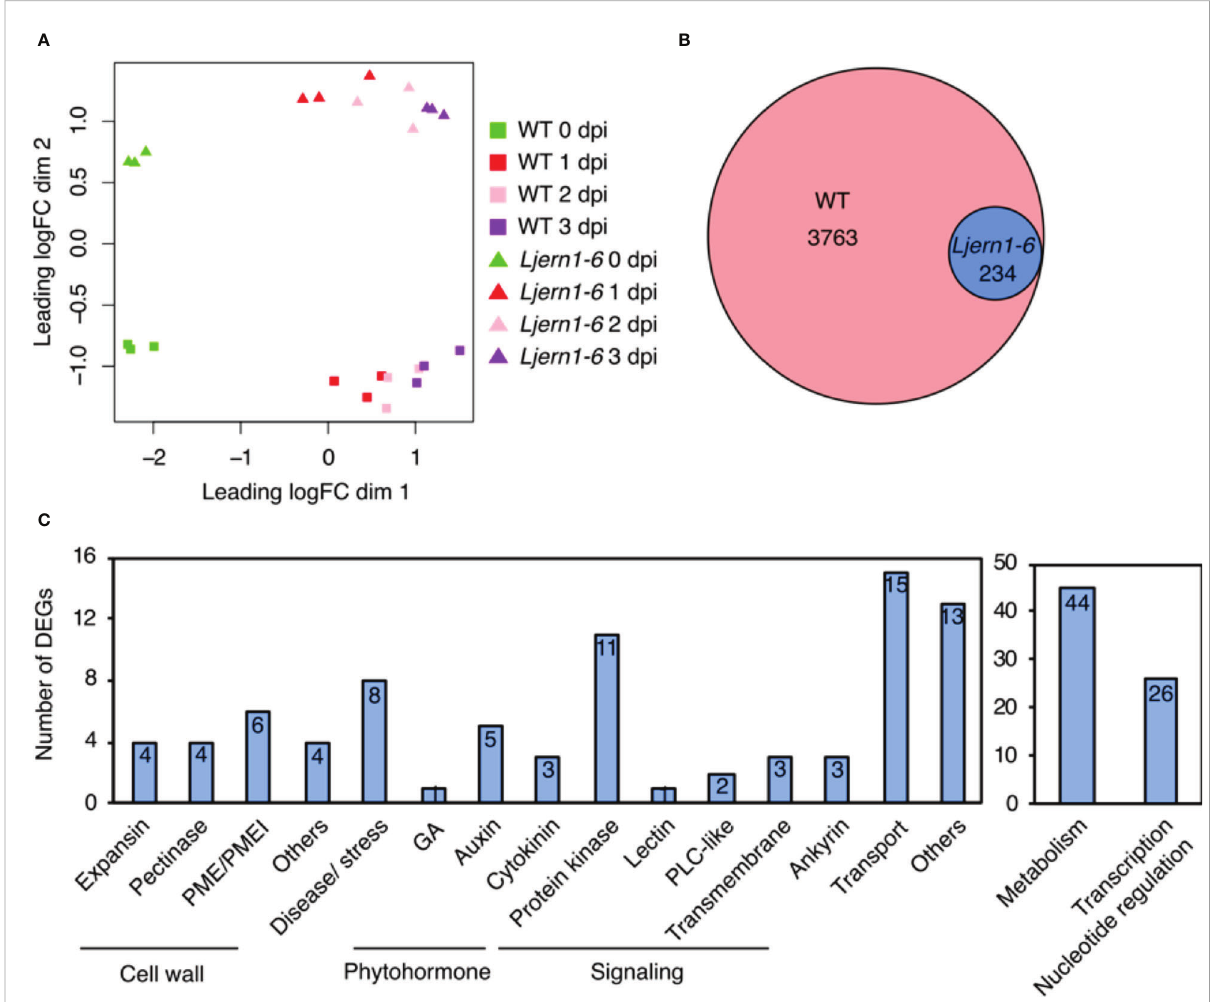
FIGURE 1 DEGs detected by RNA-seq in wild-type L. japonicus (MG-20) and Ljern1-6 mutants. (A) Multidimensional scaling plot of the effect of rhizobial infection on WT plants and Ljern1-6 mutants. (B) Proportional Venn diagram (Hulsen et al., 2008) shows the number of rhizobial infection-induced genes in WT and DEGs with decreased expression in Ljern1-6 mutants. (C) Classi fi cation of DEGs with decreased expression in Ljern1-6